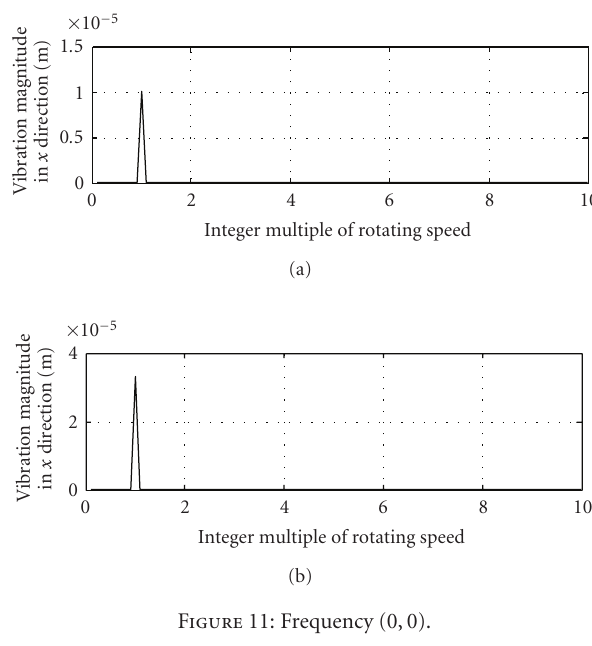
Figure 11: Frequency (0,0).